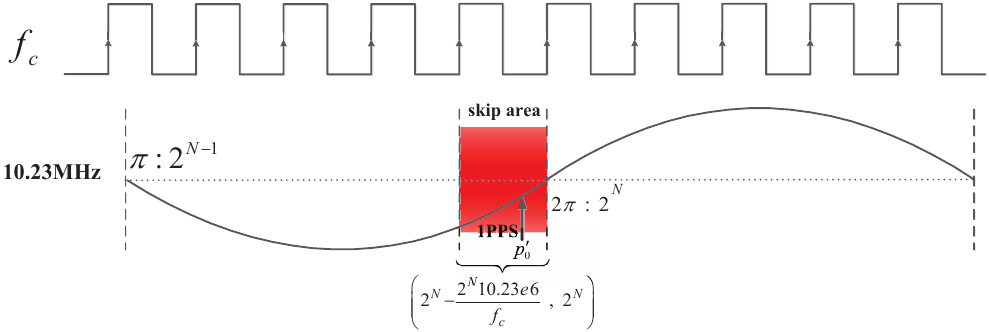
Figure 4. Skip area of the 10.23